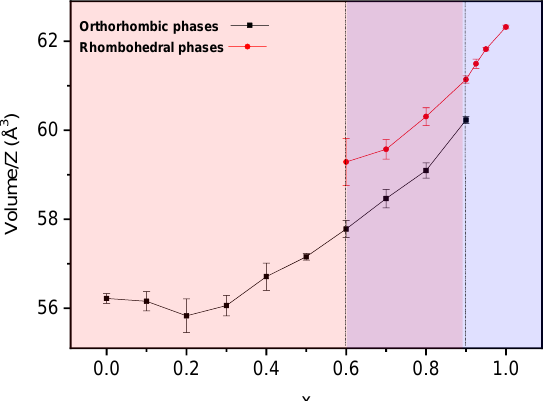
Figure 5. Unit-cell volume per formula unit with corresponding errors for the orthorhombic Pnma (S. G. No. 62) and rhombohedral R3c h (S. G. No. 161) phases in the (1 − x)YMnO 3 – xBiFeO 3 system.